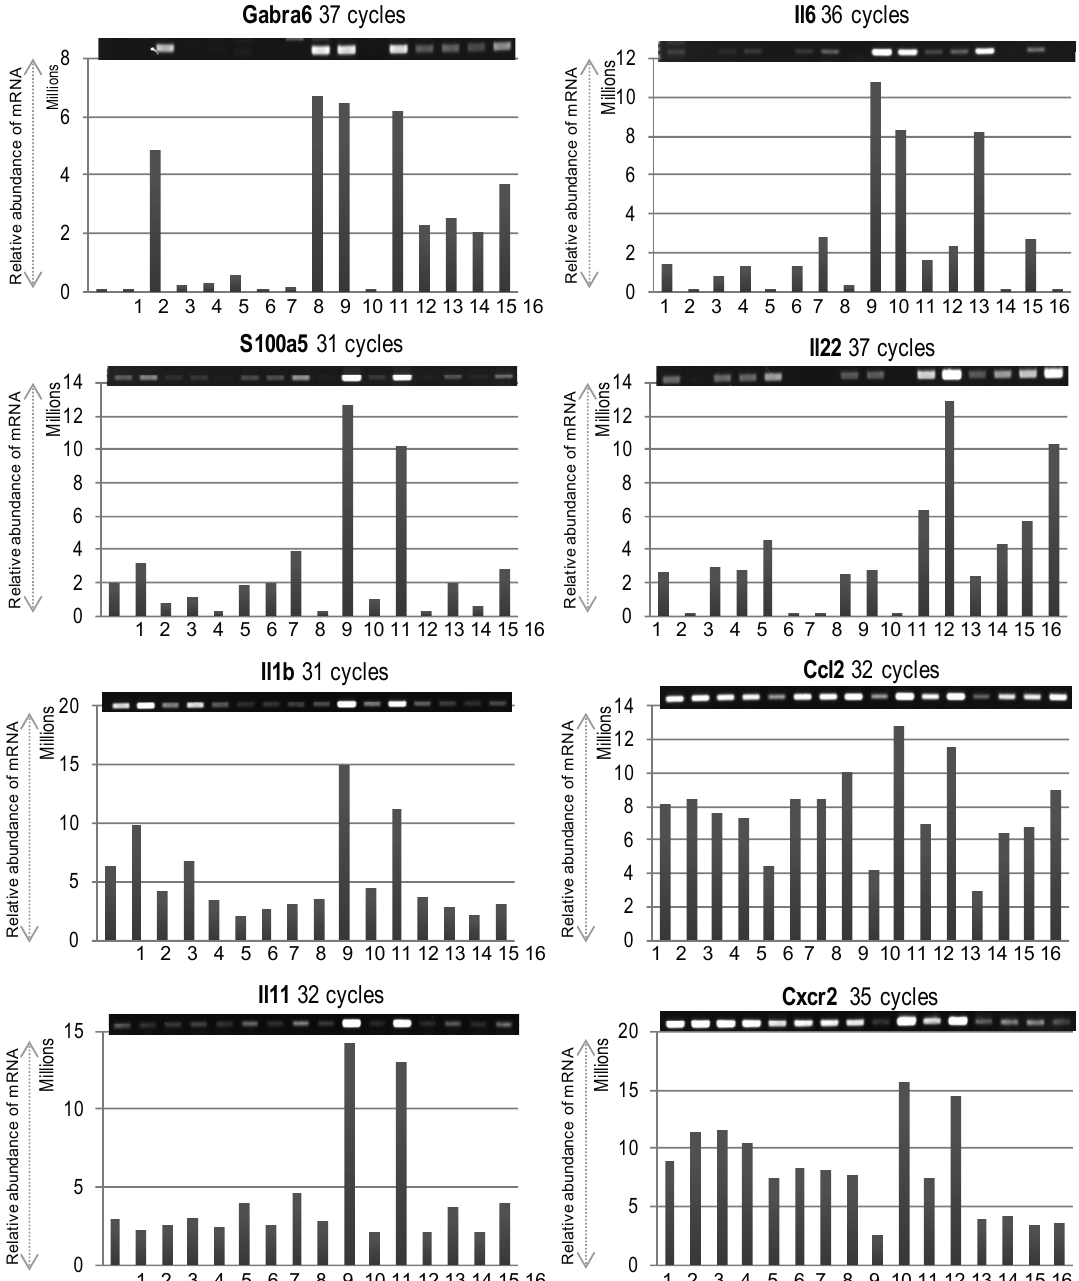
Figure 3. The mRNA expression profiles of differentially expressed up-regulated genes. Gel images on top show PCR product bands stained with ethidium bromide; band intensities are also presented graphically below for clarity. Lane numbers 1 to 8 and 9 to 16 indicate the 6 and 24 h samples ( 1 / 9 = sIC, saline Ischemic Core; 2 / 10 = pacapIC, PACAP38 Ischemic Core; 3 / 11 = sIP, saline Ischemic Penumbra; 4 / 12 = pacapIP, PACAP38 Ischemic Penumbra; 5 / 13 = sHC, saline Healthy Core; 6 / 14 = pacapHC, PACAP38 Healthy Core; 7 / 15 = sHP, saline Healthy Penumbra; 8 / 16 = pacapHP, PACAP38 Healthy Penumbra), respectively. Semi-quantitative RT-PCR was performed as described in Materials and Methods, and the gene-specific primers are detailed in Table